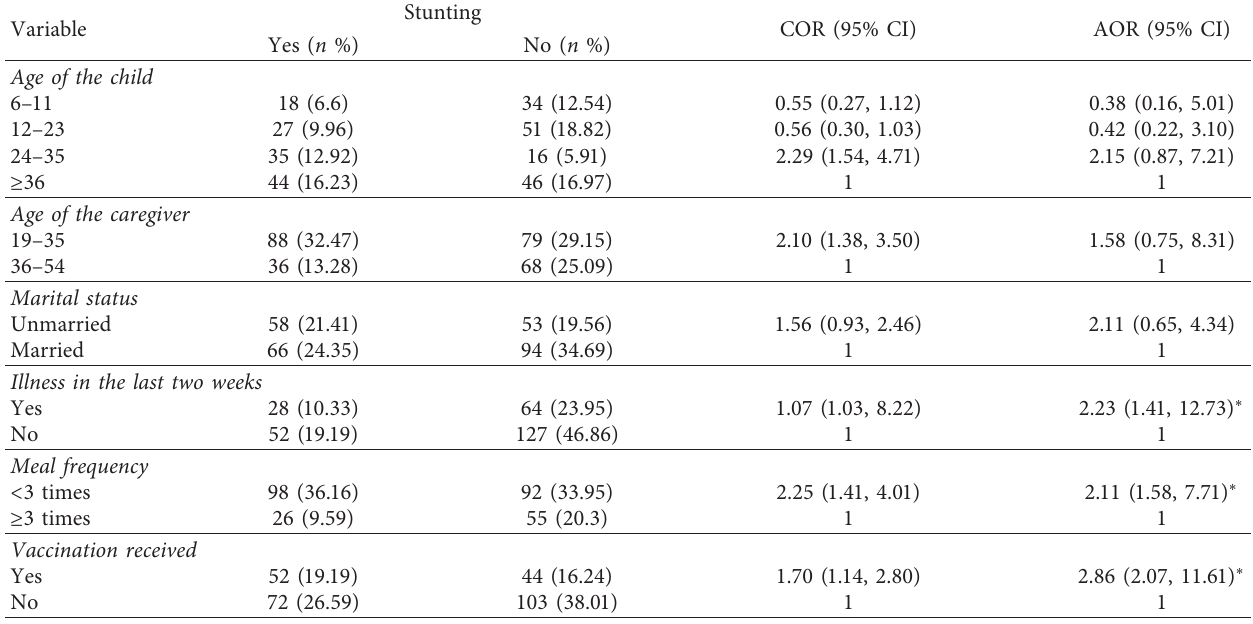
Table 4: Factors associated with stunting among orphan under-five children in Addis Ababa, Ethiopia, 2020 ( n � 271). Variable